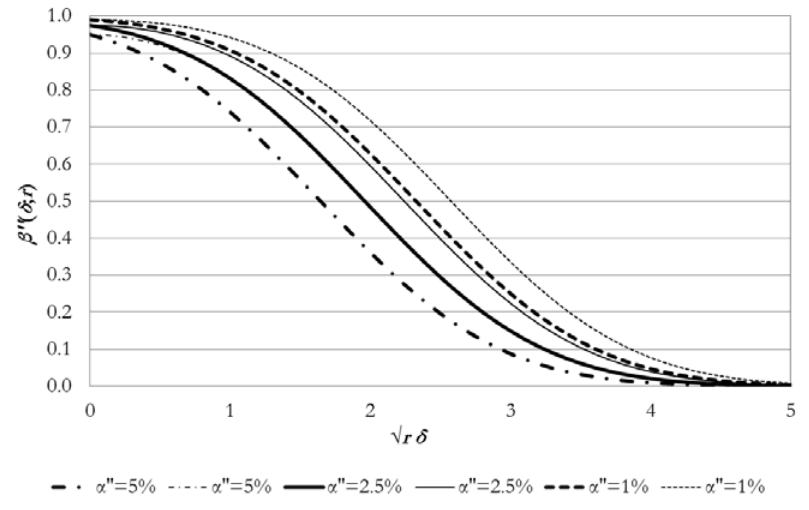
Figure 2 – Characteristic function of the conditioned test ( ) r '' ; β δ